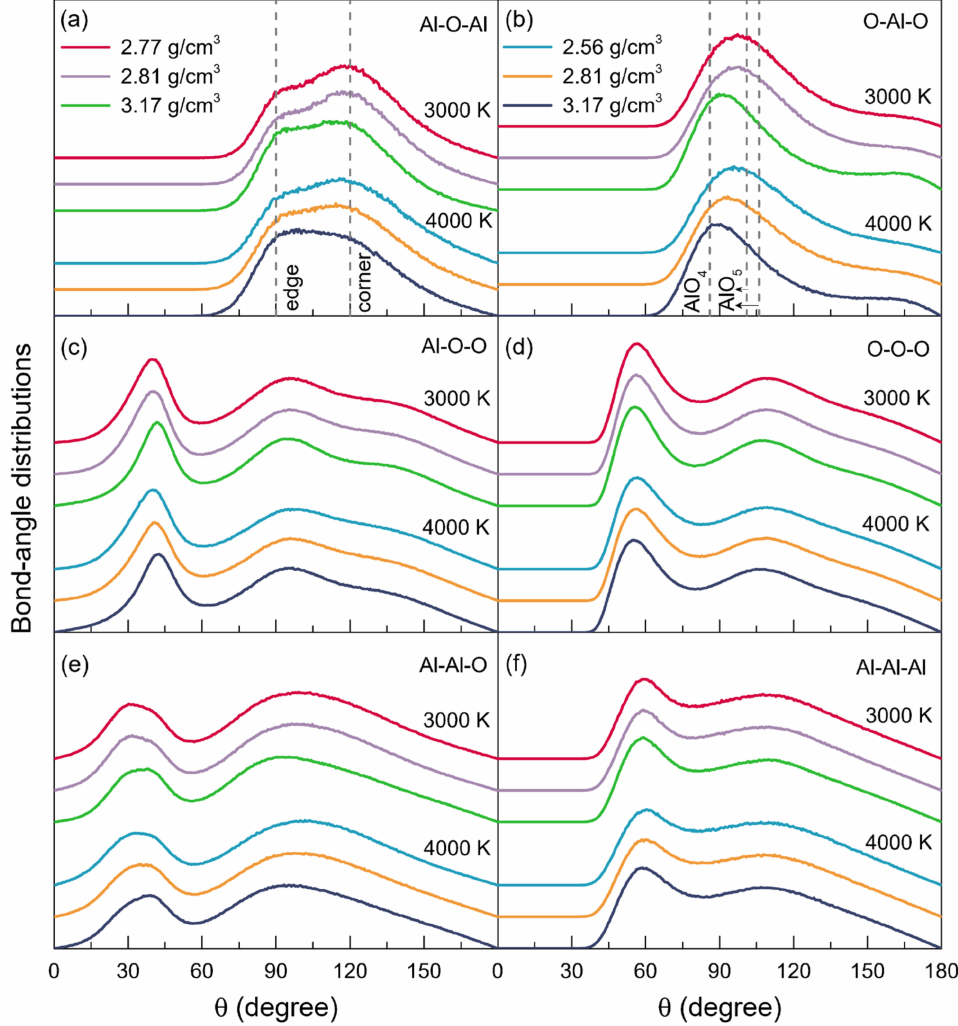
Figure 4. Bond-angle distributions for the models of liquid alumina with three densities at 3000 K and 4000 K,